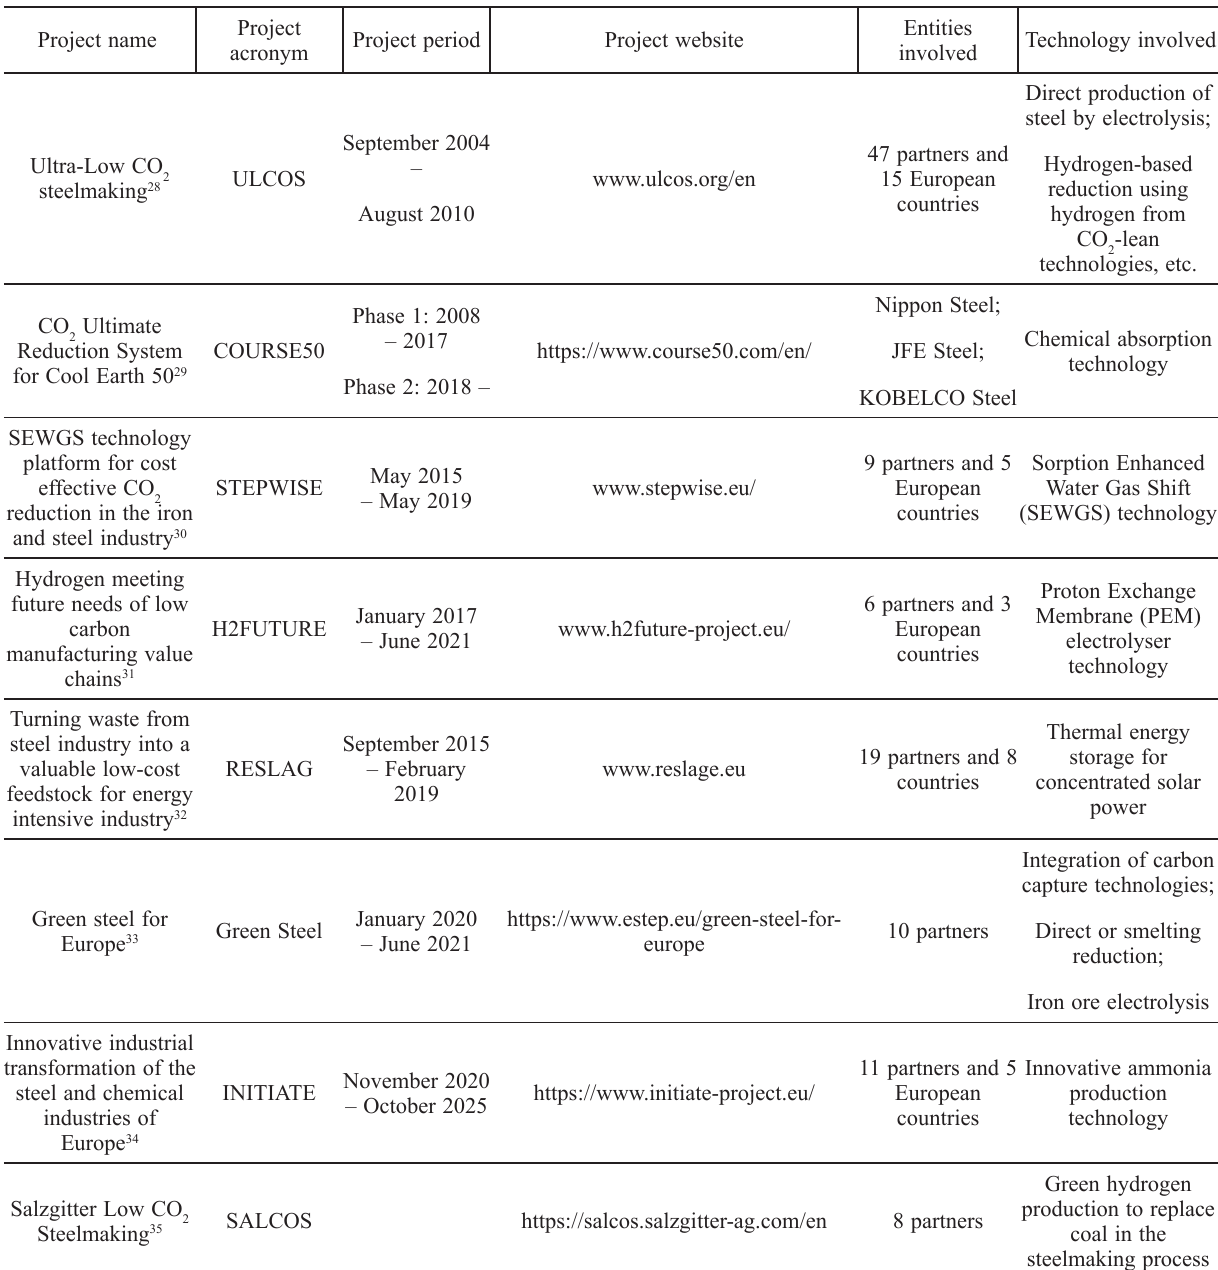
Table 2 – Projects on CCS applied to steel